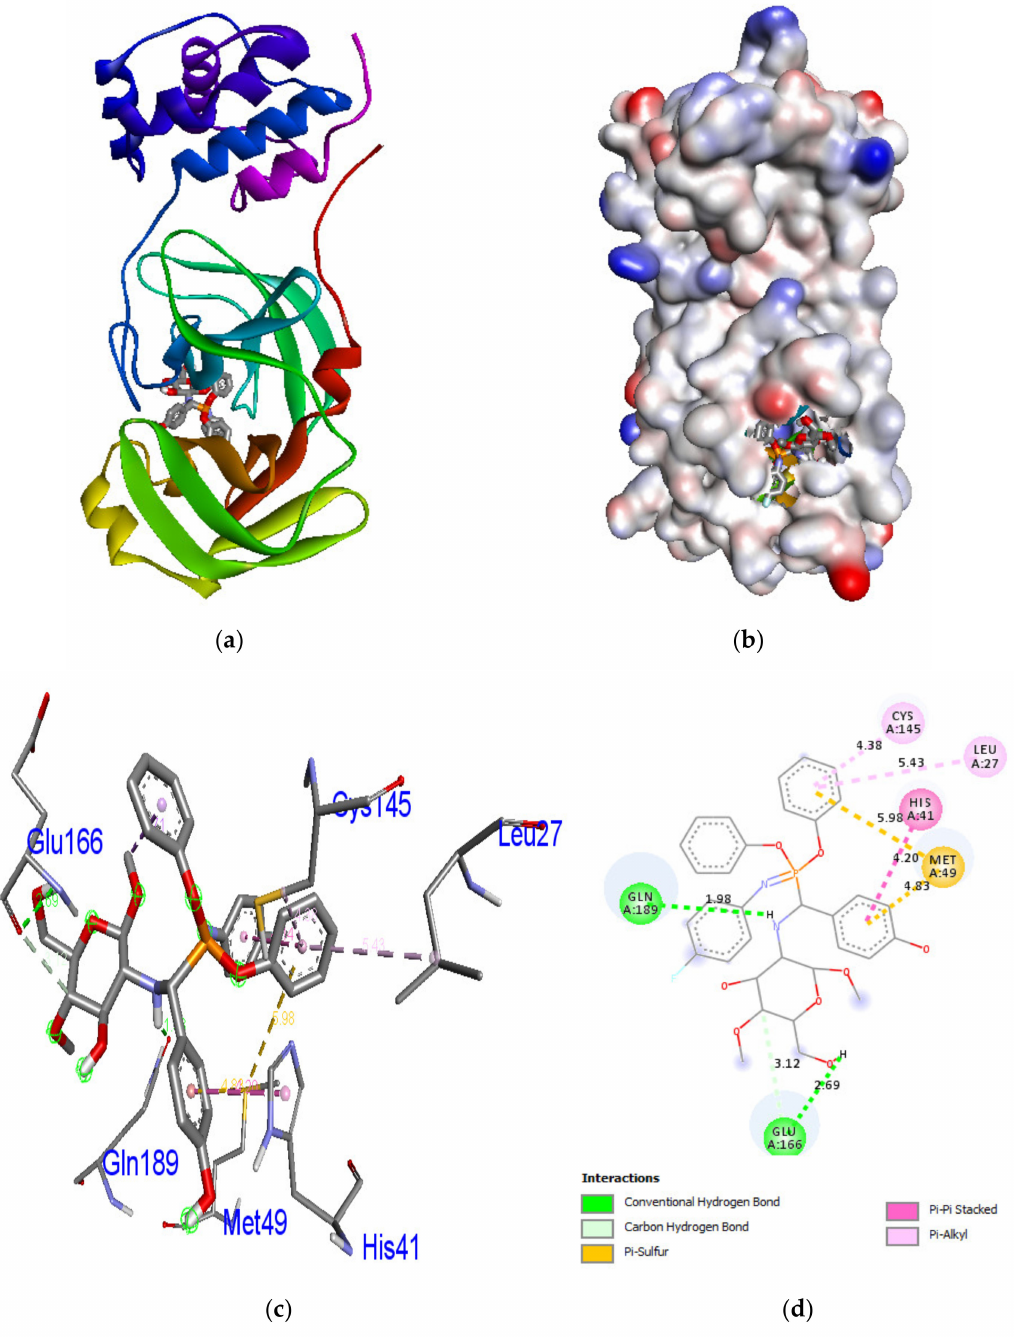
Figure 8. Helix ( a ), molecular surface ( b ), 3D ( c ), and 2D ( d ) interaction modes of compound 1c within the binding site of. 6LU7